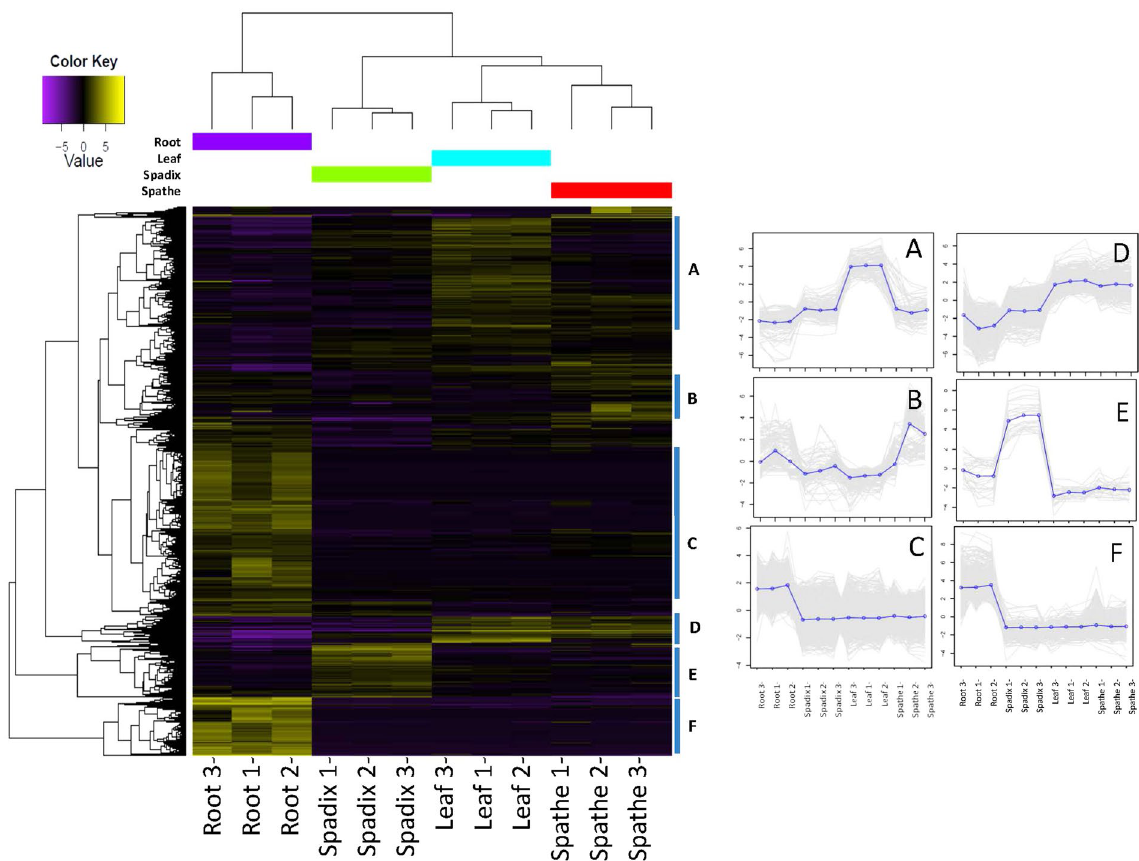
Figure 3. Expression profiles of A . amnicola unigenes across four major organs. Two dimensional clustering of organ types by expression patterns of the 10,440 differentially expressed unigenes. Cluster expression profiles are presented as inset figures ( A – F ). Vertical axis of inset figures is log 2 (median centered FPKM